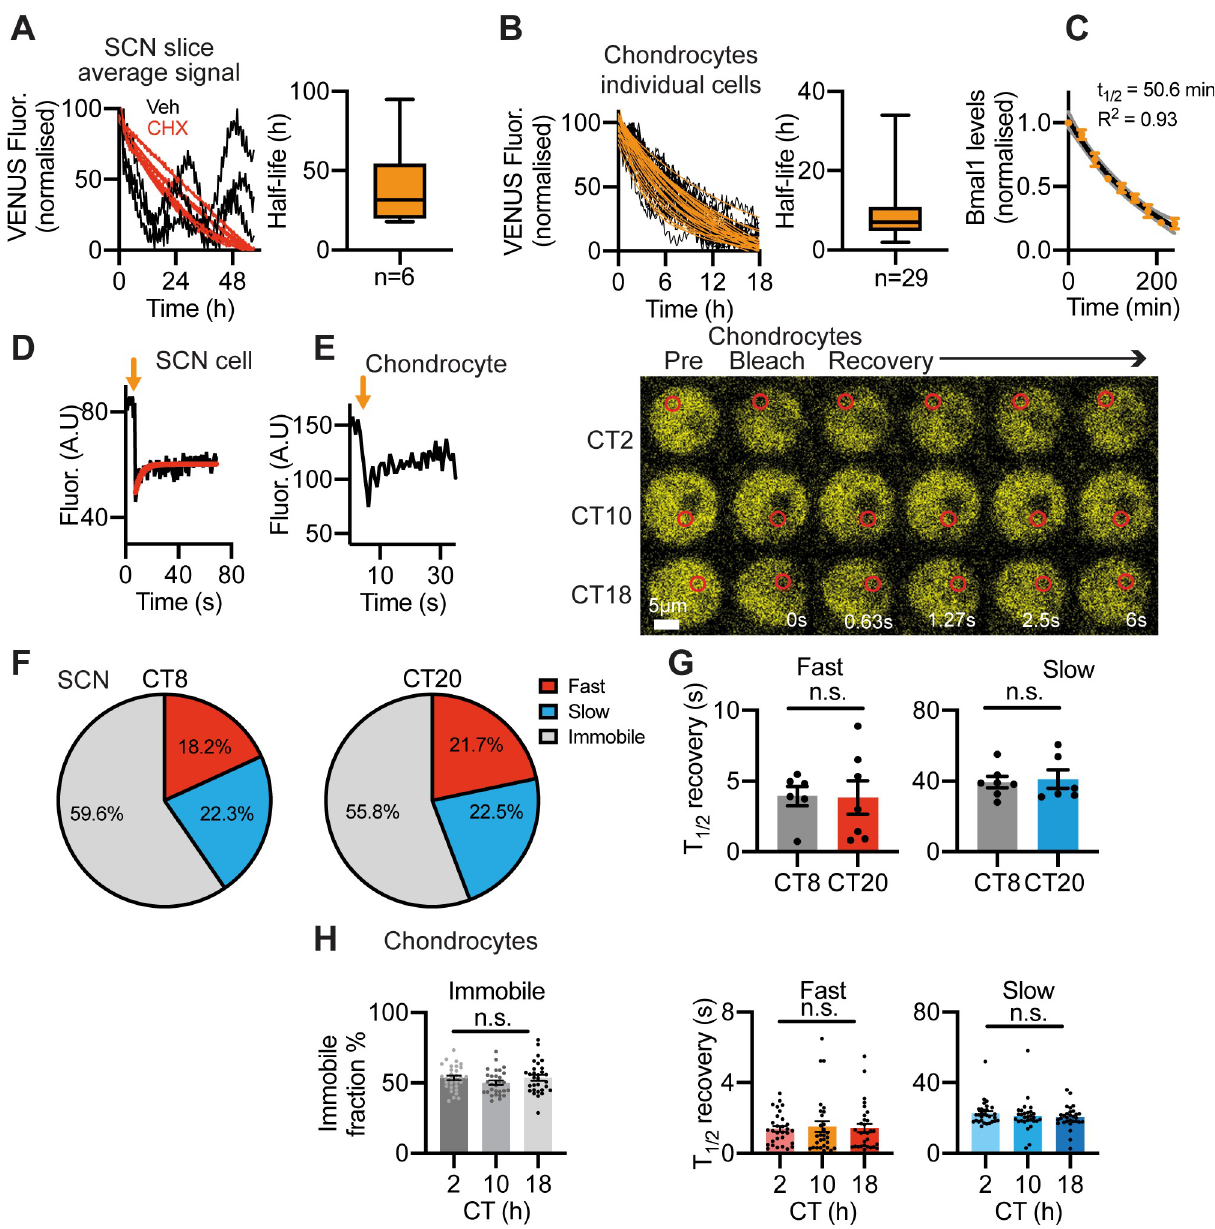
Fig 4. Quantitative analysis of Venus::BMAL1 cellular behaviour. A, B) Half-life of Venus::BMAL1 in SCN and chondrocytes was measured by time- lapse microscopy. A) Organotypic SCN slices were treated with cycloheximide (CHX) (40 μ g/mL) to stop de novo protein synthesis. Normalised average Venus fluorescence signal from confocal time-lapse recordings of CHX-treated (n = 6 red traces) were compared to vehicle-treated control slices (n = 3 black traces). Note that decline in signal was not complete after 60 hours, thus, half-life measures were estimated from best-fit. Box and whisker plot showing median and interquartile ranges for the half-life of Venus::BMAL1 in SCN slices. B) (Left) Venus::BMAL1 half-life in primary chondrocytes (n = 29 cells). Cells were treated with CHX 5 μ g/mL to stop de novo protein synthesis. Right) Box and whisker plot showing median and interquartile ranges for the half-life of Venus::BMAL1 in chondrocytes. C) Bmal1 mRNA stability in primary chondrocytes. Time (min) is following actinomycin D treatment (5 μ g/mL). D) Example FRAP experiment showing partial fluorescence recovery after nuclear bleach in the SCN at CT20. E) FRAP analysis in the nucleus of chondrocytes. Left: Fluorescence recovery curve after nuclear bleach. Right: Representative fluorescence images of FRAP experiments in chondrocytes at CT2, 10 and 18. CT0 represents 24 hrs post-dexamethasone. F) FRAP analysis in the nucleus of the SCN revealed two components (fast and slow) of the diffusion kinetics of Venus::BMAL1, as well as an immobile fraction. Pie charts for FRAP analysis of SCN slices at CT8 and CT20 (relative to PER2::Luc rhythms) show percentage of signal explained by fast component, slow component and immobile component in 2-component diffusion model. G) Mobility of Venus::BMAL1 molecules expressed as t 1/2 of FRAP recovery. Both the fast component (left) and slow component (right) lack a time-of-day effect (mean ± SEM; n = 6). Data were fitted to a 2-component diffusion model, where a fast and a slow component were identified. Note, such high mobility of BMAL1 is in line with other transcription factors in the cell nucleus, but contrasts with the slow kinetics of DNA-